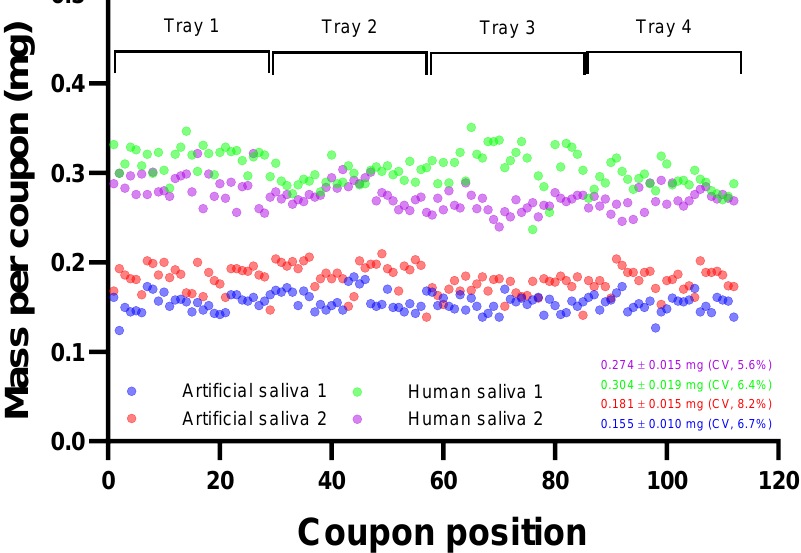
Figure 2. Deposition reproducibility on coupons as a function of position within aerosol deposition box. Artificial saliva 1 is MEL only; artificial saliva 2, human saliva 1 and 2 are mixtures of MEL and SS304. Fluorescence values are converted to mass through knowing the mass in g · L − 1 of total solids in the spray suspension and the fluorescence of the initial spray suspension.